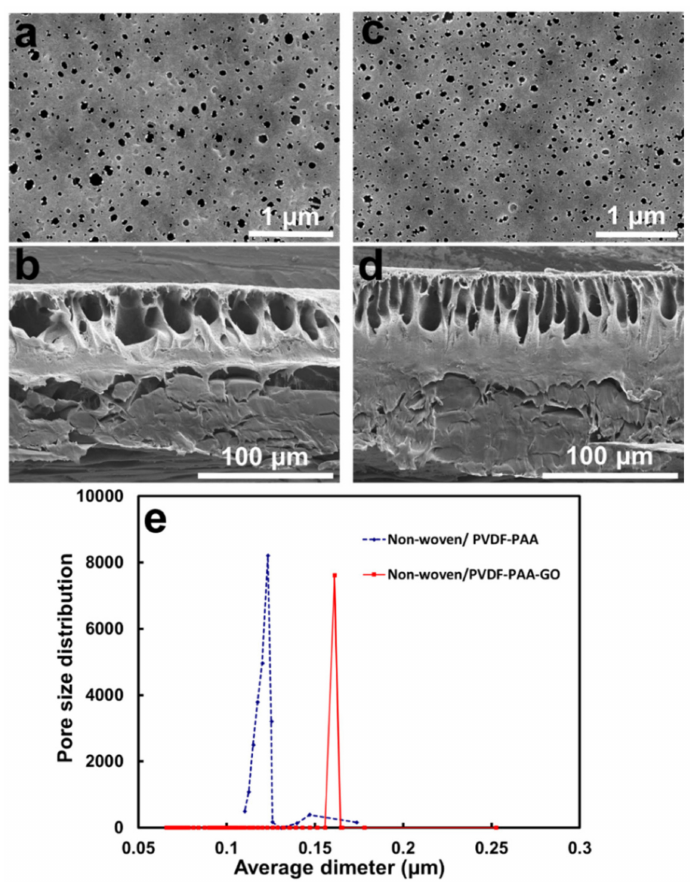
Figure 2. Microstructure of ( a ) top surface and ( b ) cross-section of non-woven/PVDF-PAA composite. ( c ) Top surface and ( d ) cross-section of non-woven/PVDF-PAA-GO composite. ( e ) shows the pore size distribution of non-woven/PVDF-PAA and non-woven/PVDF-PAA-GO membranes.